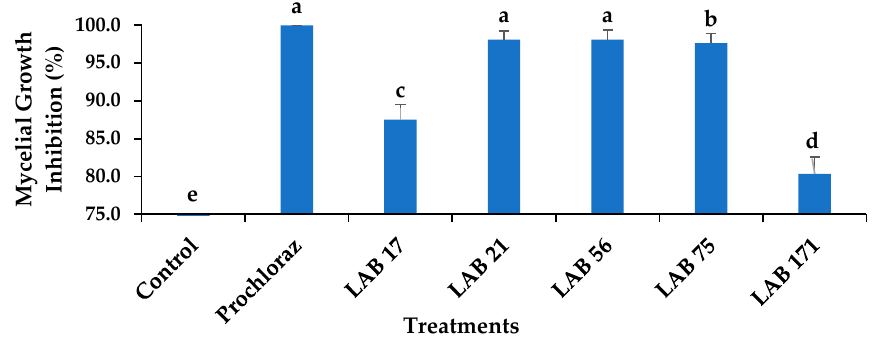
Figure 1. Effects of LAB strains on the mycelial growth inhibition of Colletotrichum gloeosporioides after 7 days of incubation at 26 ± 2 °C. Each error bar represents the standard deviation of the mean of five replicates. Columns with different letters were significantly different at p ≤ 0.05 level. Keys: